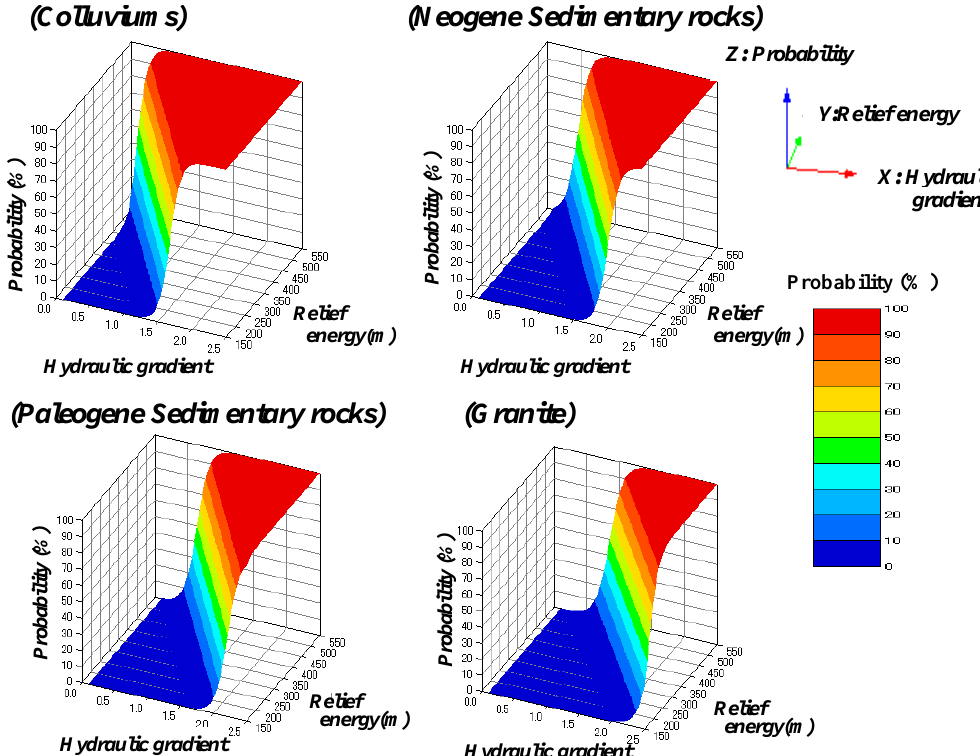
(Granite) (Paleogene Sedimentary rocks)